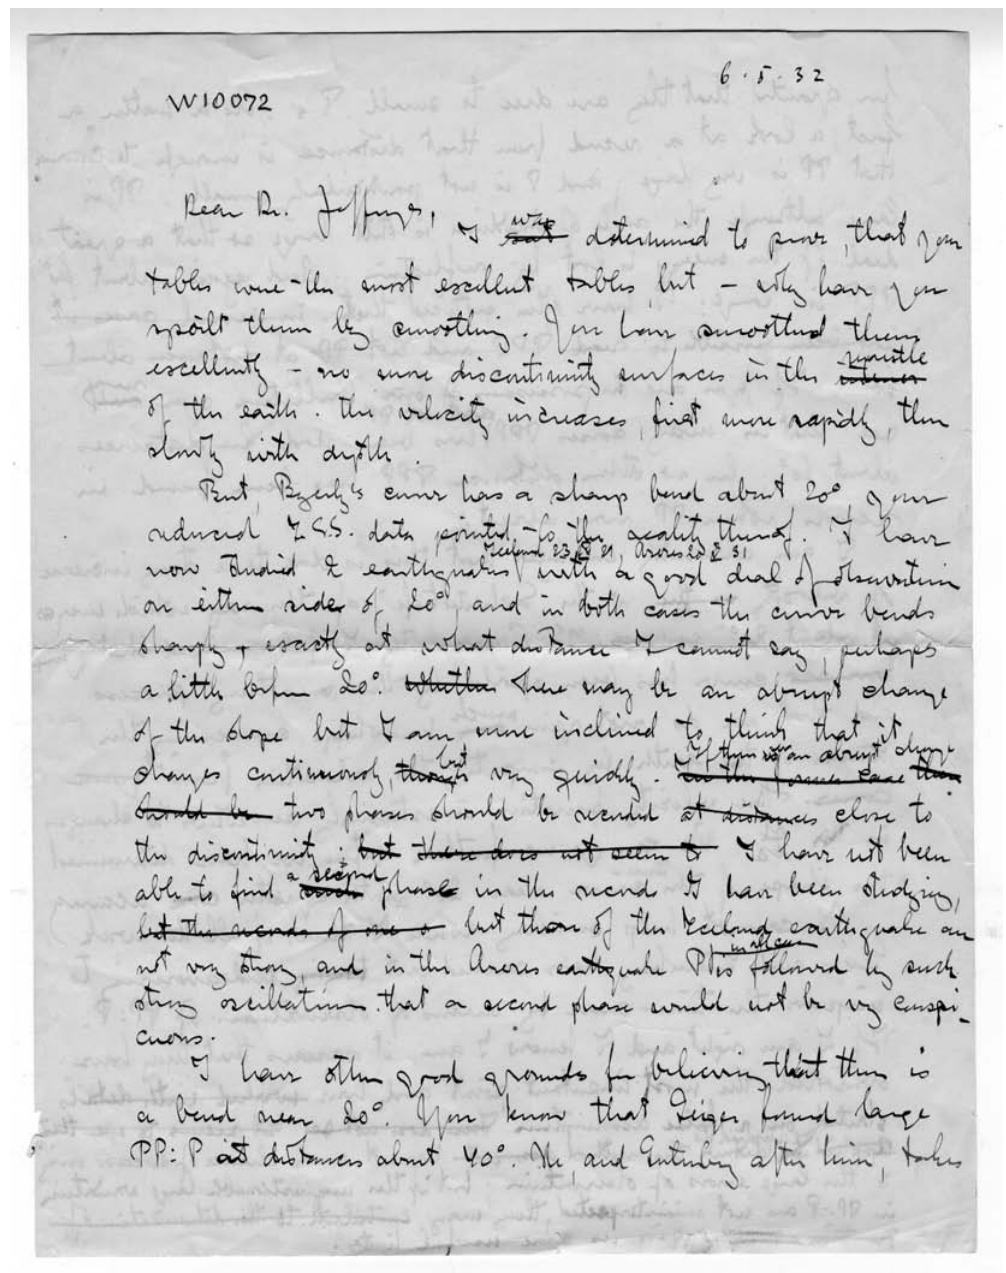
Fig. 6. First page of Inge Lehmann’s May 6, 1932 letter to Harold